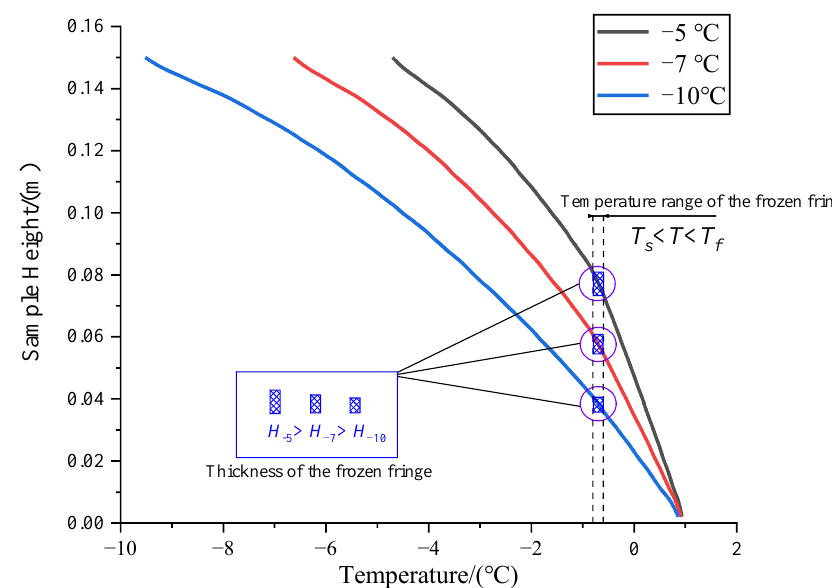
Figure 10. Temperature distribution along height at different cold end temperatures at 2400 min.